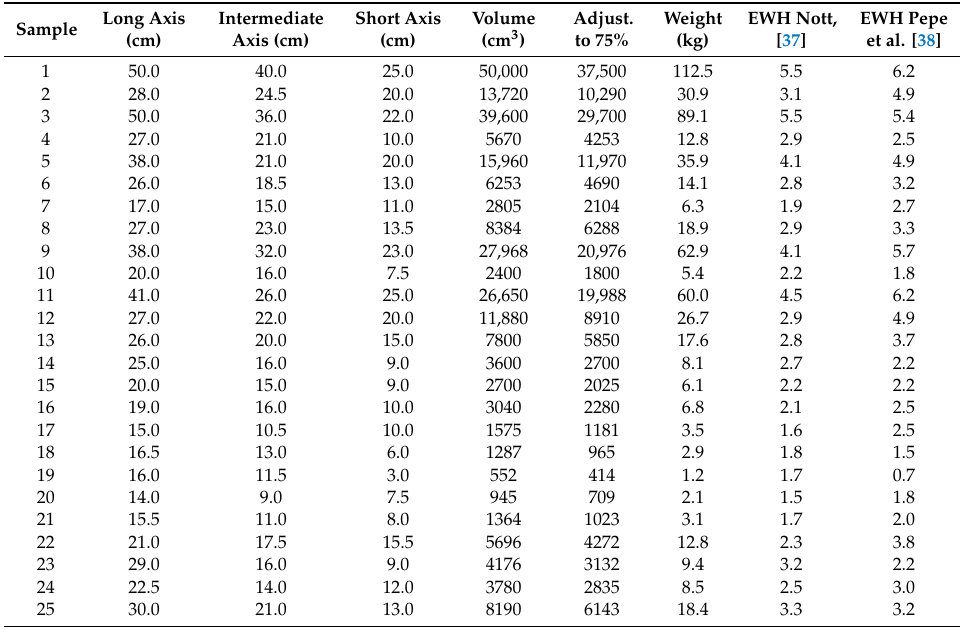
Table7. Quantificationofbouldersize, volume, andestimatedweightfromthePleistoceneconglomerate at site 7 at Ponta do Cedro, on the east shore of Santa Maria Island (see map, Figure 1b). The standard density of basalt at 3.0 gm / cm 3 was applied uniformly in order to calculate wave height for each boulder. EWH: estimated wave height (in meters), calculated from equations in Nott [37] and Pepe et al. [38]. See the methods Section 3.2. (hydraulic